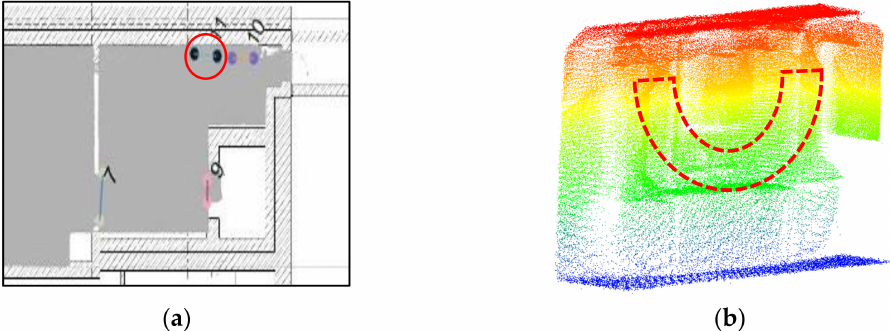
Figure 20. Comparison of the detection results ( a ) with point clouds ( b